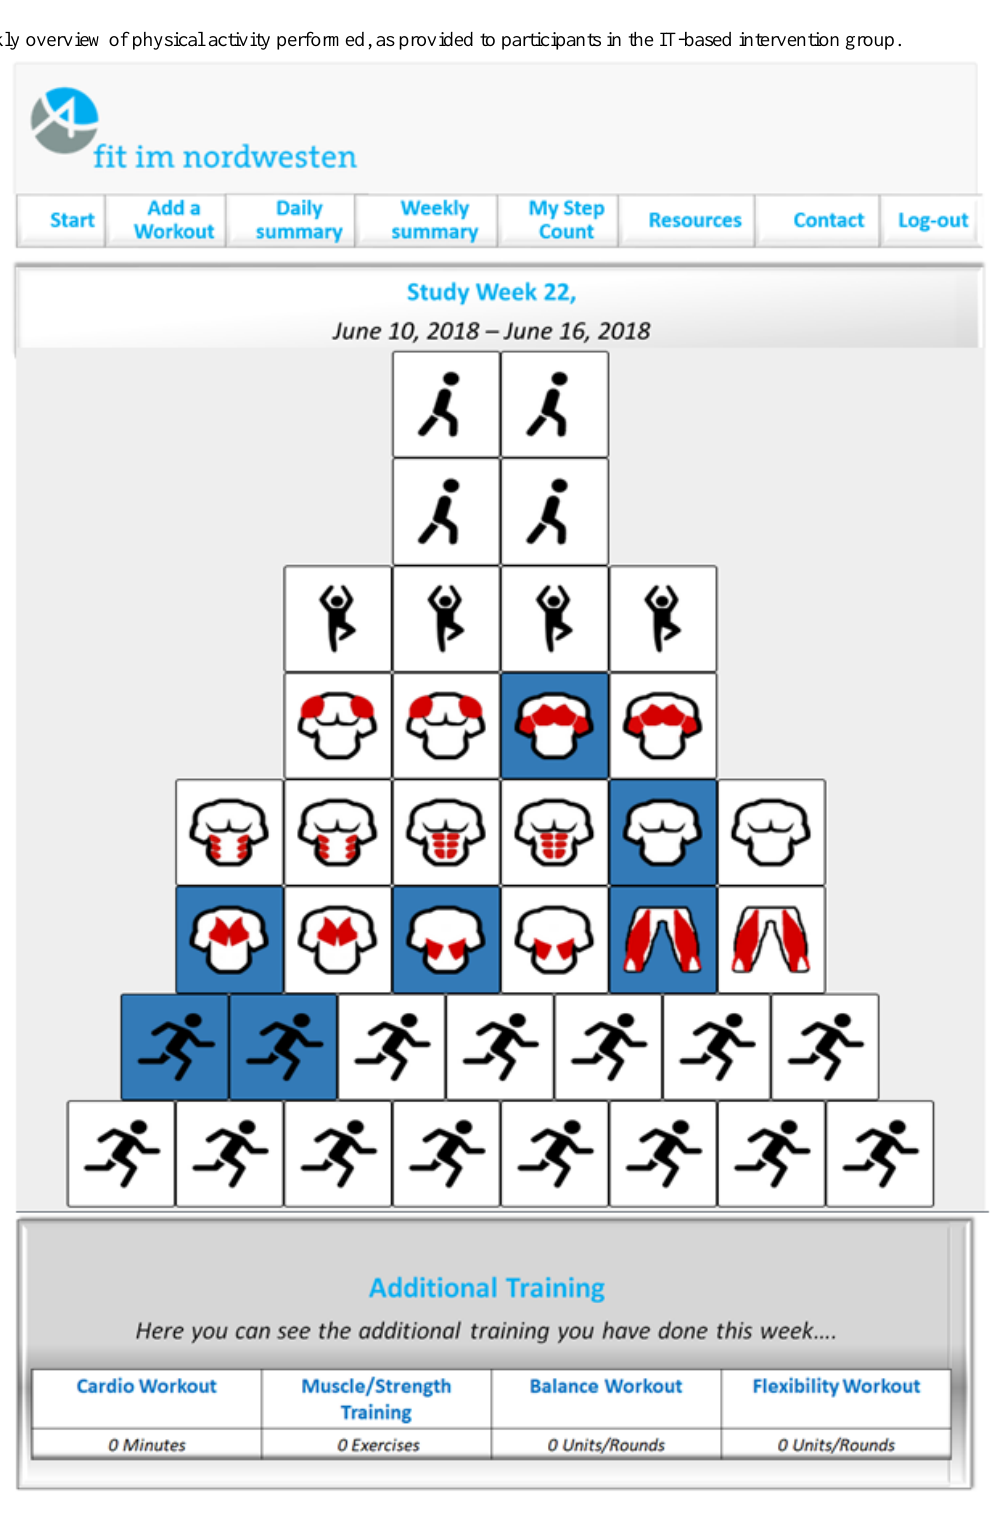
Figure 2. Weekly overview of physical activity performed, as provided to participants in the IT-based intervention